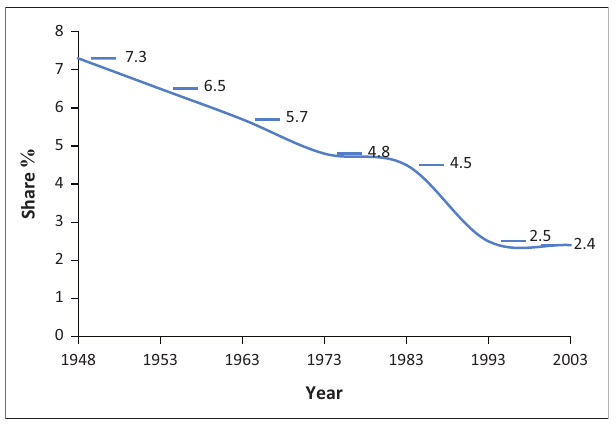
Source : Figure constructed based on data from WTO, 2005, International trade statistics 2005, World Trade Organization, Switzerland. FIGURE 1: African merchandise export share of global export (1948–2003).